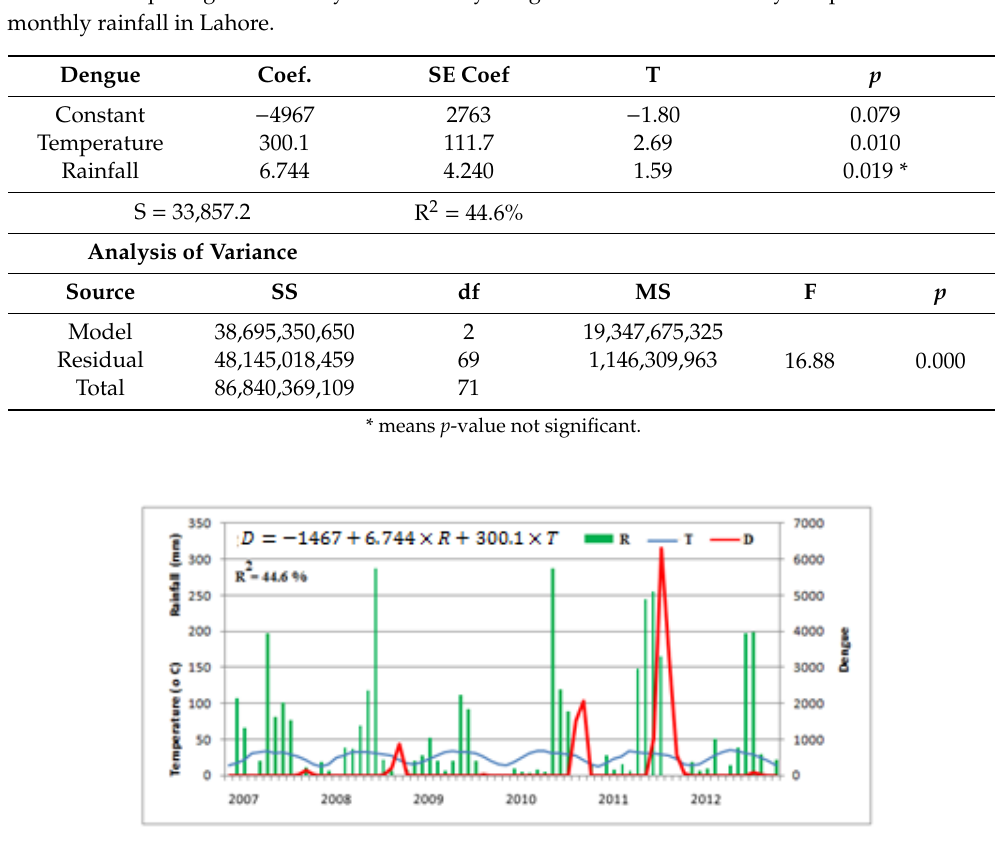
Figure 11. The plot of total monthly dengue (D) versus climatic factors (i.e., monthly temperature (T) and rainfall (R)) with multiple regression equation in Lahore, 2007–2012.